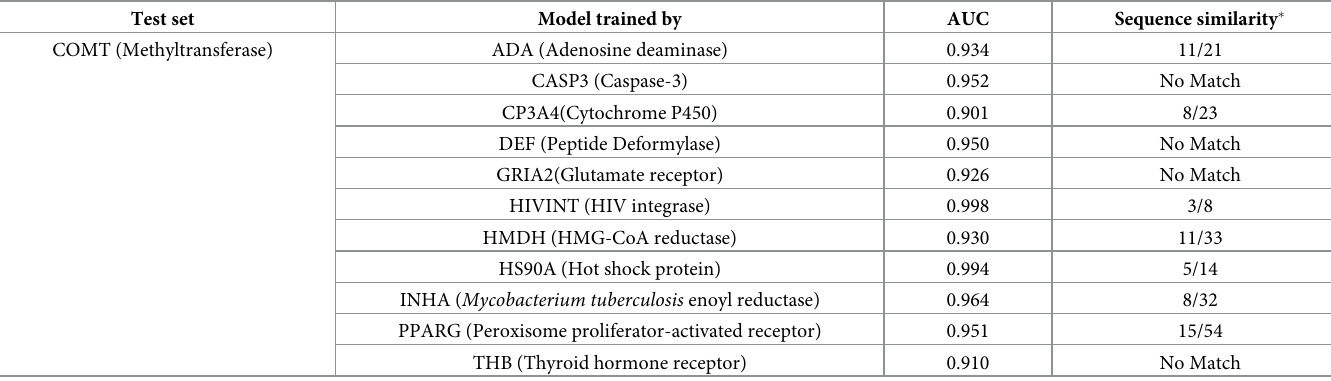
Table 2. Ligand-only CNN models that achieved high AUC (greater than 0.9) for COMT. Test set Model trained by AUC Sequence similarity � COMT